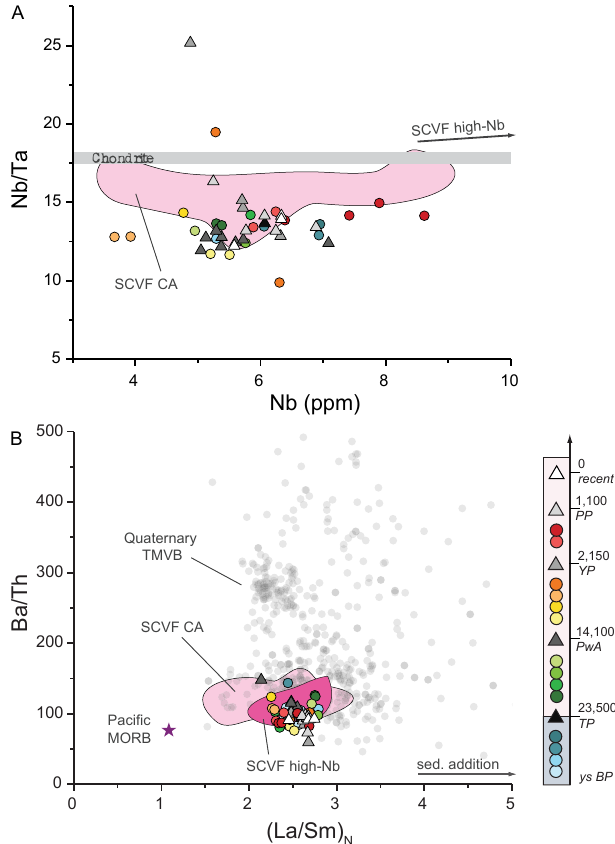
Figure 7: Trace element plots detailing source charac- teristics of PVC volcanic rocks. [A] Nb/Ta vs Nb, with calc-alkaline SCVF rocks for reference. [B] Ba/Th vs (La/Sm)N, with Pacific MORB, SCVF and quaternary volcanic rocks from the TMVB for reference. AOC = Altered Oceanic Crust. SCVF data from Straub et al. [2015]; quaternary TMVB data compiled from GeoRoc; average Pacific MORB data o ff shore Mexico from